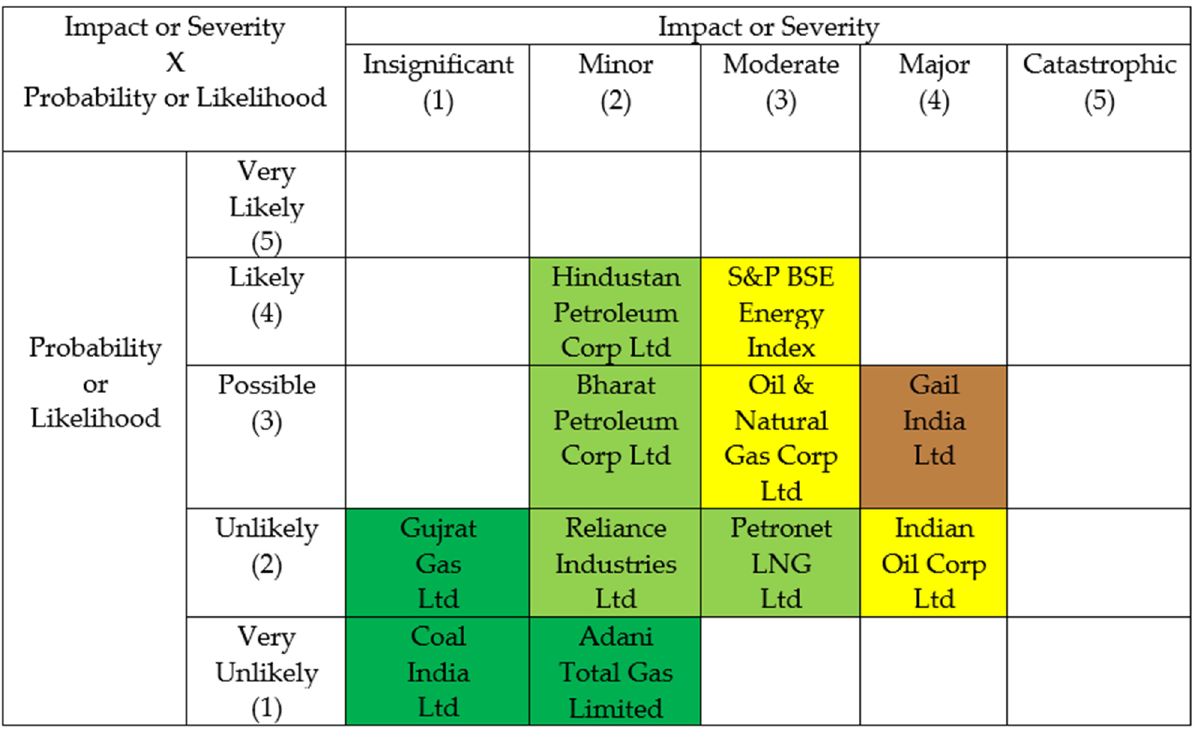
Figure 8. S&P BSE Energy Index and Top Ten Companies’ Risk Exposure. Source: Author’s contri- bution.